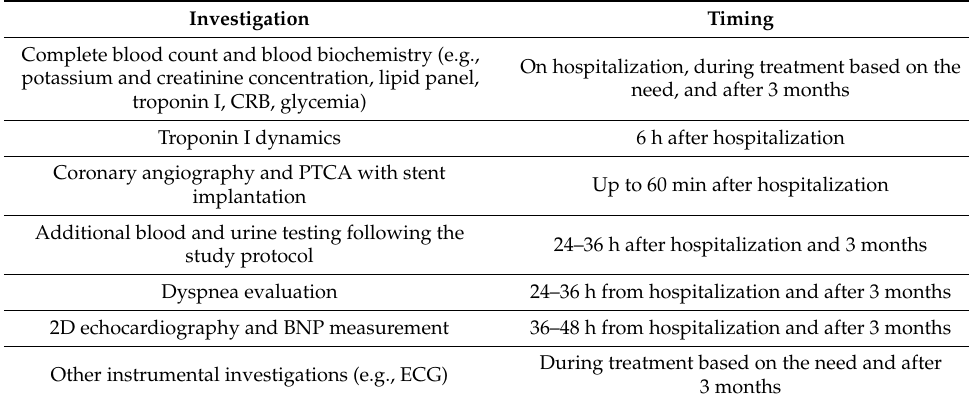
Table 1. Investigations and their timing.